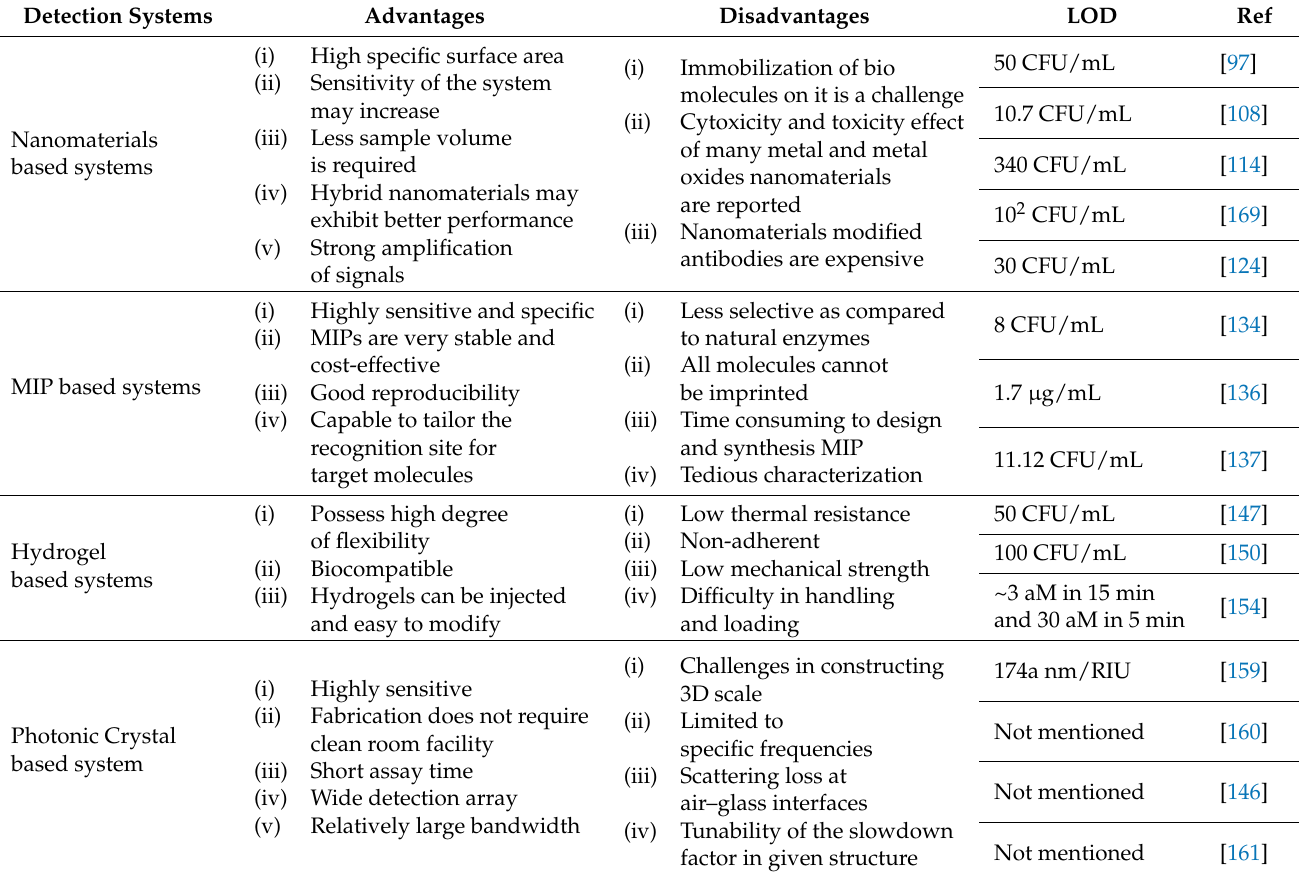
Table 3. Emerging smart materials as pathogen detection systems. Detection